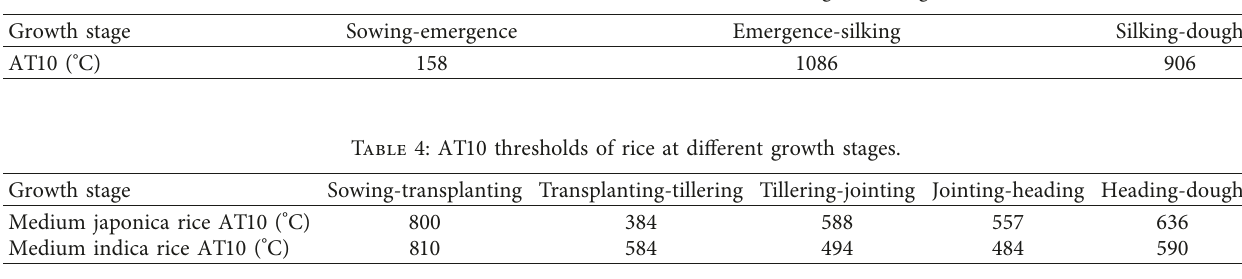
Table 3: AT10 thresholds of summer maize at different growth stages.